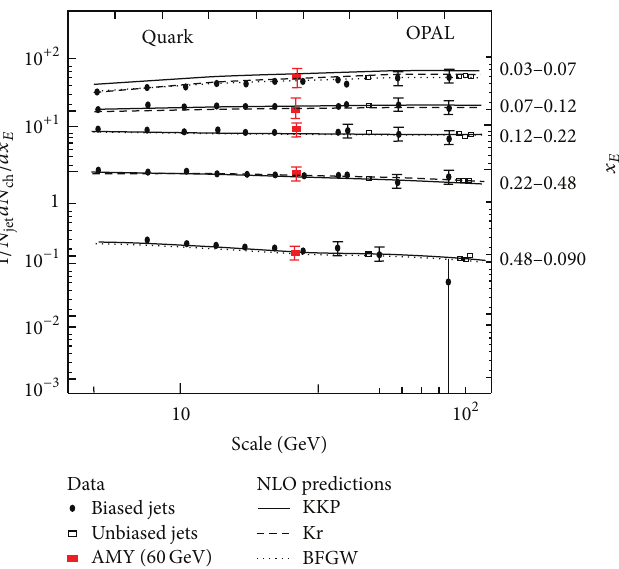
Figure 10: Scale dependence of the quark fragmentation function in different 𝑥 𝐸 ’s intervals [12–15].